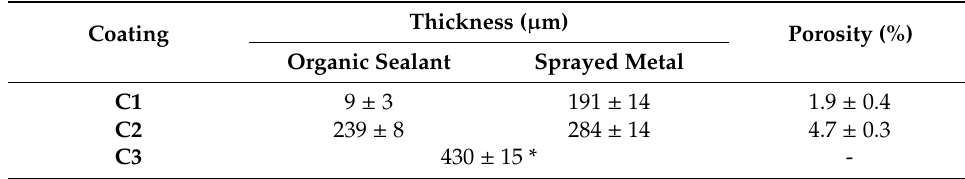
Table 2. Mean thickness and porosity values measured for the three coatings [20]. C1: a thermally sprayed carbide coating with an organic sealant; C2: a thermally sprayed aluminum (TSA) with an organic topcoat; C3: an epoxydic organic coating reinforced with ceramic platelets.